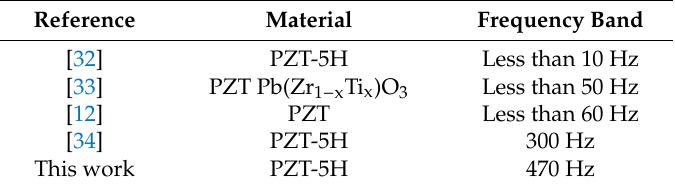
Figure 5. Comparison of theoretical and simulated results. Table 3. Comparisons of working frequency band.